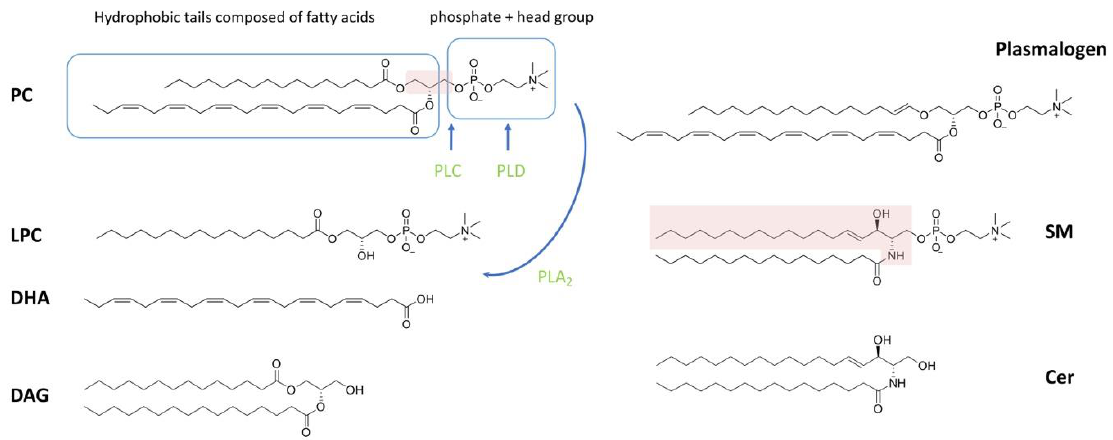
Figure 1. Chemical structure of lipids. The pink shading in phosphatidylcholine (PC) shows the glycerol backbone. The pink shading in sphingomyelin (SM) shows the sphingoid backbone. The blue line boxes show the main parts of PC, the hydrophobic tail and the polar head, respectively. The distinction of PC and plasmalogen is whether the linkage at sn-1 is through an ether bond or ester bond. PC can be hydrolyzed by phospholipase A 2 (PLA 2 ) to LPC and fatty acid. Phospholipase C (PLC) and phospholipase D (PLD) act on the phosphate group and headgroup of phospholipids to break down phospholipids into DAG and PA, respectively. Phospholipases are shown in green and blue straight arrows indicate positions of catalysis.